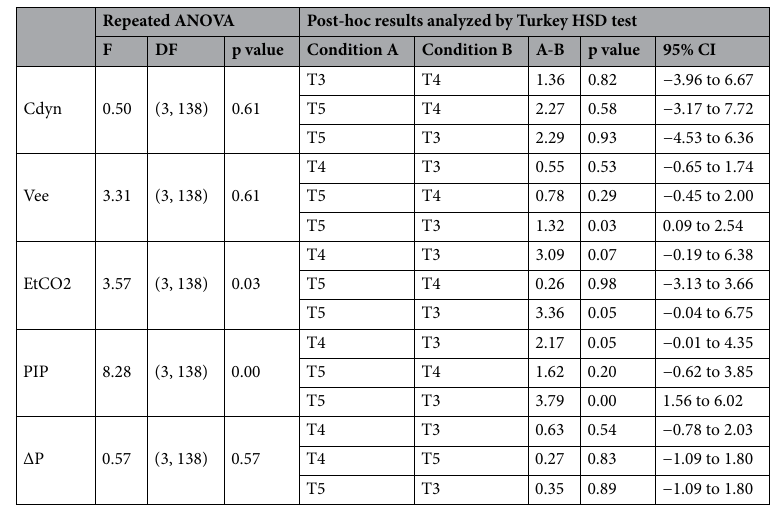
Table 2. Change in respiratory parameters during APT (T3, T4, and T5). DF, degree of freedom; OR, odds ratio; CI, confidence interval; ETCO 2 , end-tidal CO 2 monitoring, Cdyn: change in dynamic lung compliance; Vee, Velocity of end-expiratory flow; ETco2, end-tidal carbon dioxide concentration; ΔP, driving pressure; APT, artificial pneumothorax; PIP, peak inspiratory pressure.